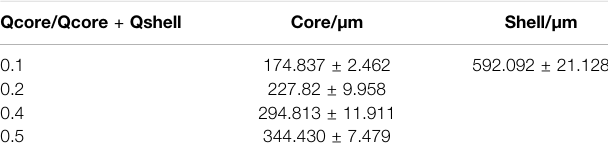
TABLE 3 | Average diameter of core-shell structure under different core-shell liquid fl ow ratio. Qcore/Qcore +